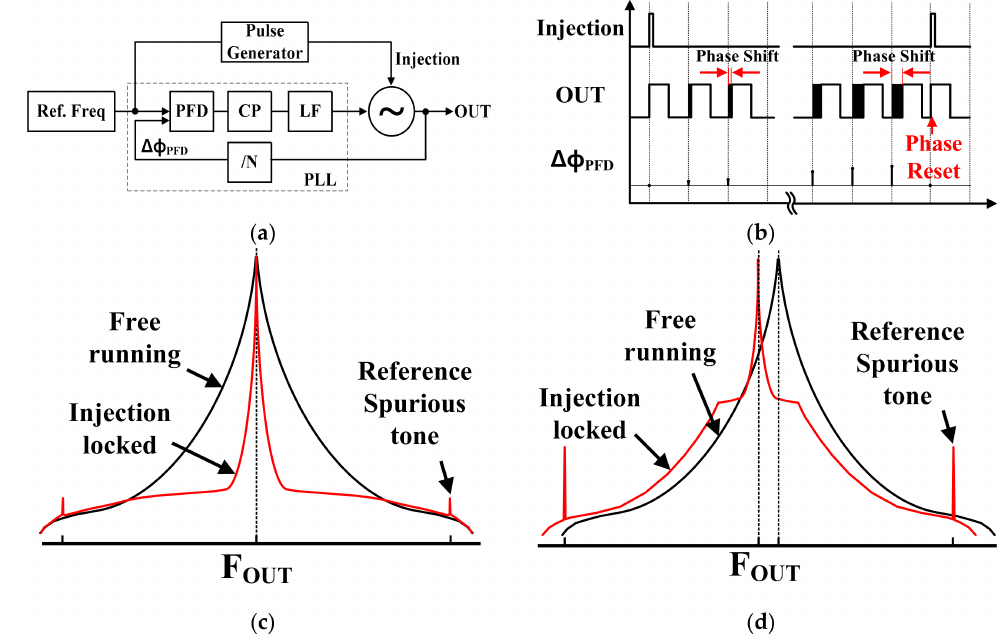
Figure 3. ( a ) Block diagram; ( b ) timing diagram of conventional ILFM; ( c ) phase noise of ILFM without frequency error; and ( d ) with frequency